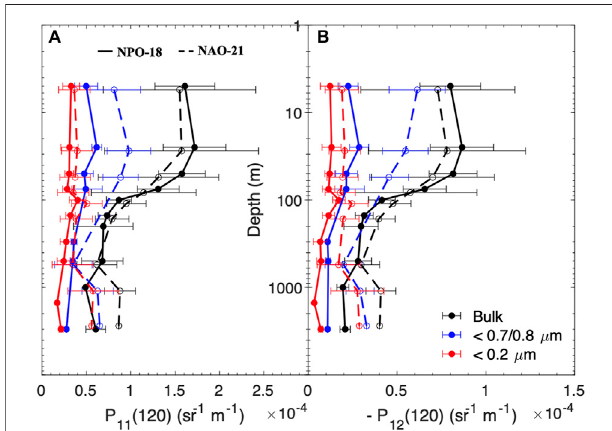
FIGURE 3 | (A) Depth variations of P 11 (A) and − P 12 (B) at 120 ° (median ± one standard deviation) for un fi ltered (Bulk), 0.7/0.8- μ m fi ltered ( < 0.7/0.8 μ m), and 0.2- μ m fi ltered ( < 0.2 μ m) samples in the NPO-18 (solid circle + solid line) and NAO-21 (open circle + dash line) sites. For better visualization, the depth of NAO-21 data was shifted downward by 10% of the original depth.